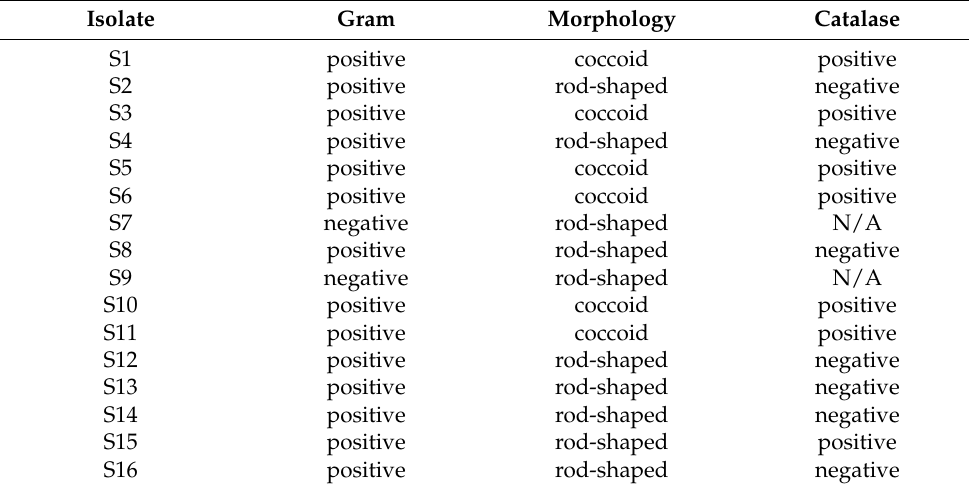
Table 3. Morphological characteristics and catalase activity of 16 isolates obtained from the intestinal content of rainbow trout. Isolate Gram Morphology Catalase S1 positive coccoid positive S2 positive rod-shaped negative S3 positive coccoid positive rod-shaped